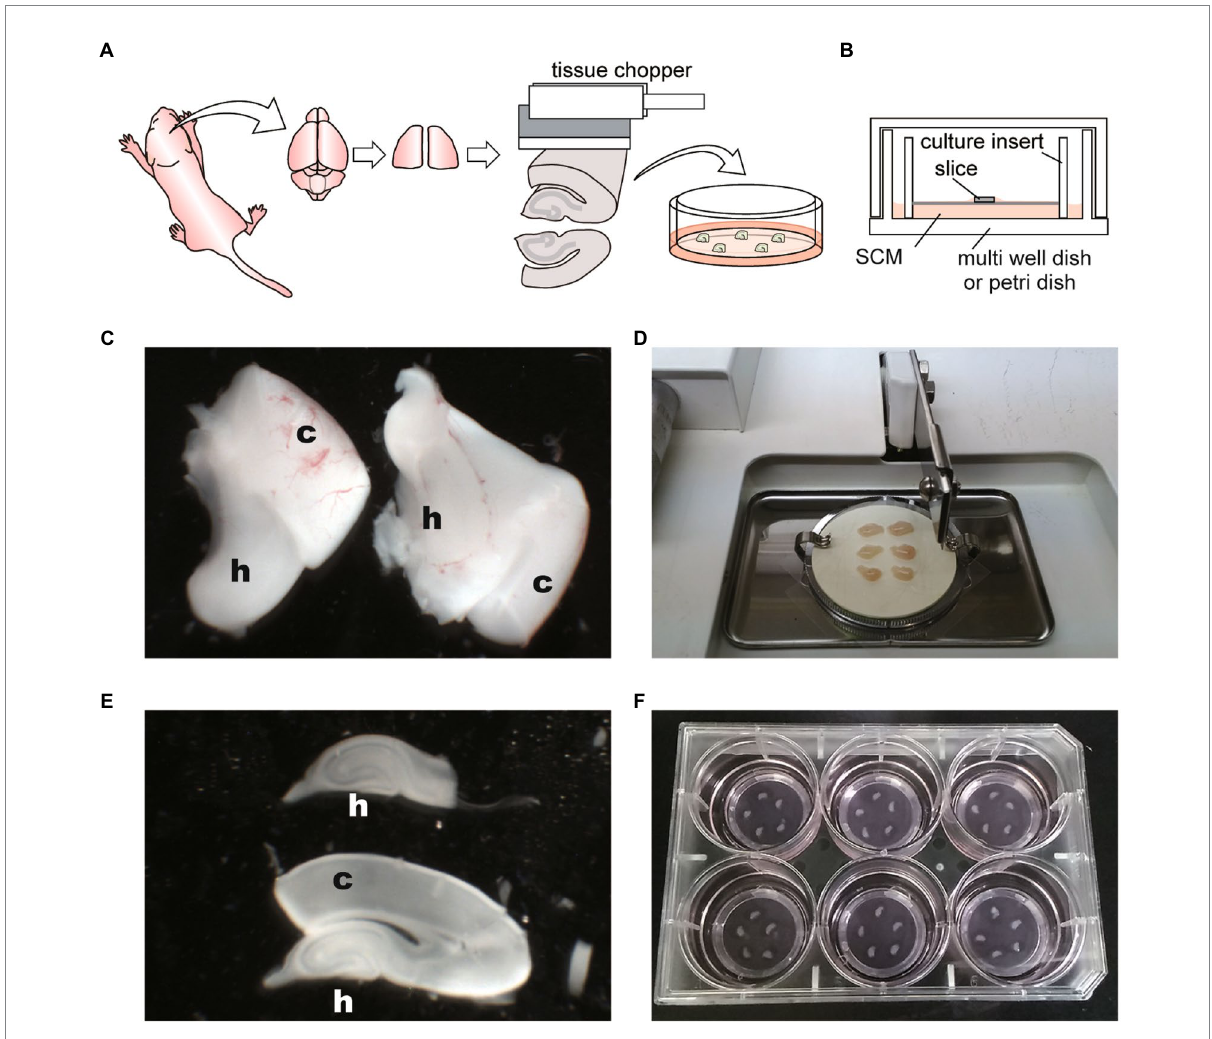
FIGURE 1 Schematic diagrams and photographs of procedure for hippocampal slice culture. (A) Schema of hippocampal slice culture method. (B) Schema representing disposition of slice on membrane culture insert and within the culture dish. SCM: slice culture medium. (C) Image of isolated hippocampi (H) with cerebral cortex (c). (D) Image of tissue chopper and isolated hippocampi with the cerebral cortex. Six hippocampi were placed on an OHP sheet in the cutting chamber. (E) Sliced hippocampus (h) with the cortex (c) and isolated hippocampus. (F) Five slices were placed onto the filter membrane cup in the six-well plate with SCM. Hippocampal slices are not located close to the cup walls of the inserts or close to each